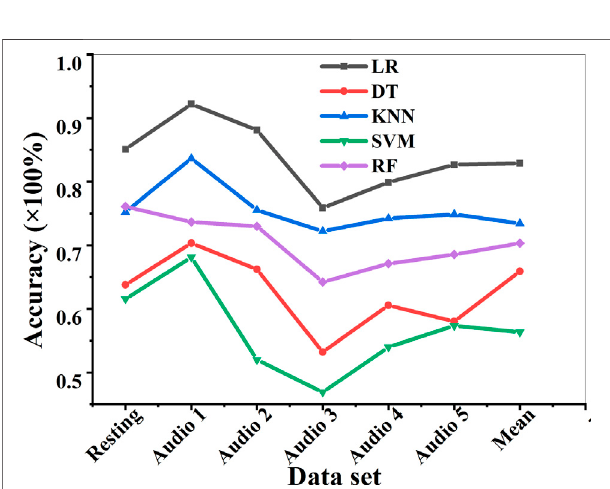
FIGURE 10 | Analysis on the accuracy of EEG feature selection under different conditions.